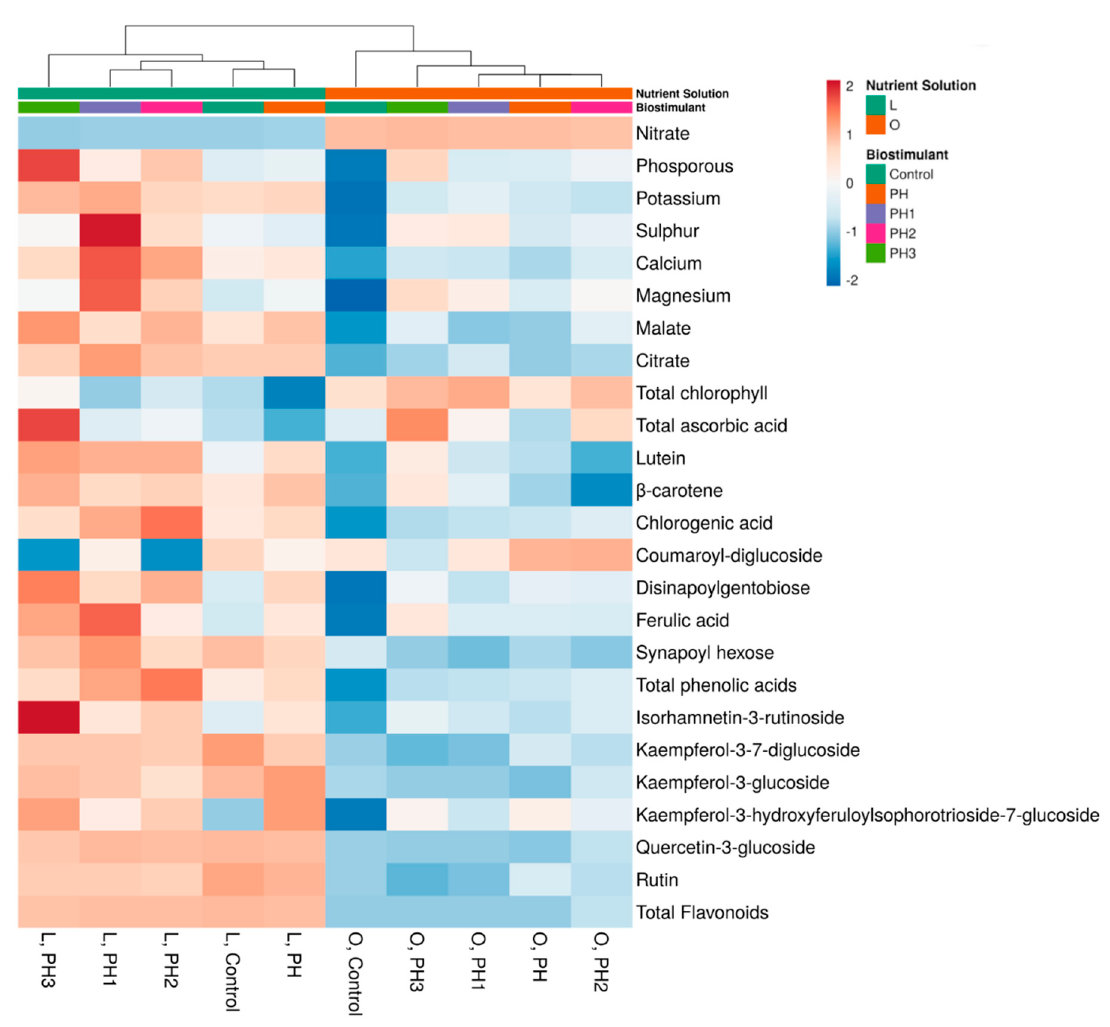
Figure 2. Cluster heat map analysis summarizing lettuce plants response to nitrogen dosage and biostimulant application . Original values are ln (x + 1)-transformed. Columns are clustered using Euclidean distance and complete linkage. PH: protein hydrolysate; molecular fractions PH1, PH2 and PH3 (>10 kDa, between 1 and 10 kDa, < 10 kDa).